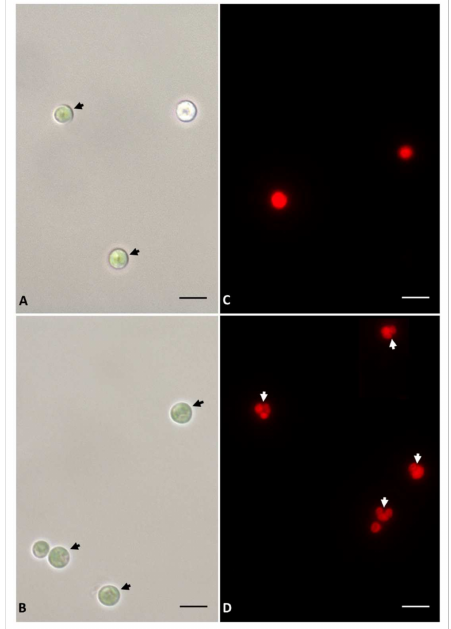
Figure 2. Images in light and in fluorescence microscopy of Galdieria sulphuraria cells collected after 2 days from the start of experiment. Light microscopy: ( A ): control cells. ( B ): S starved cells. In both analysed samples are evident cells with a rounded shape (dark arrow). Fluorescence microscopy: ( C ): control cells. ( D ): S starved cells. In S starved cells some daughter cells (autospores) before hatching (white arrow) are apparent. ( A – D ): Bars correspond to 5 µ m.